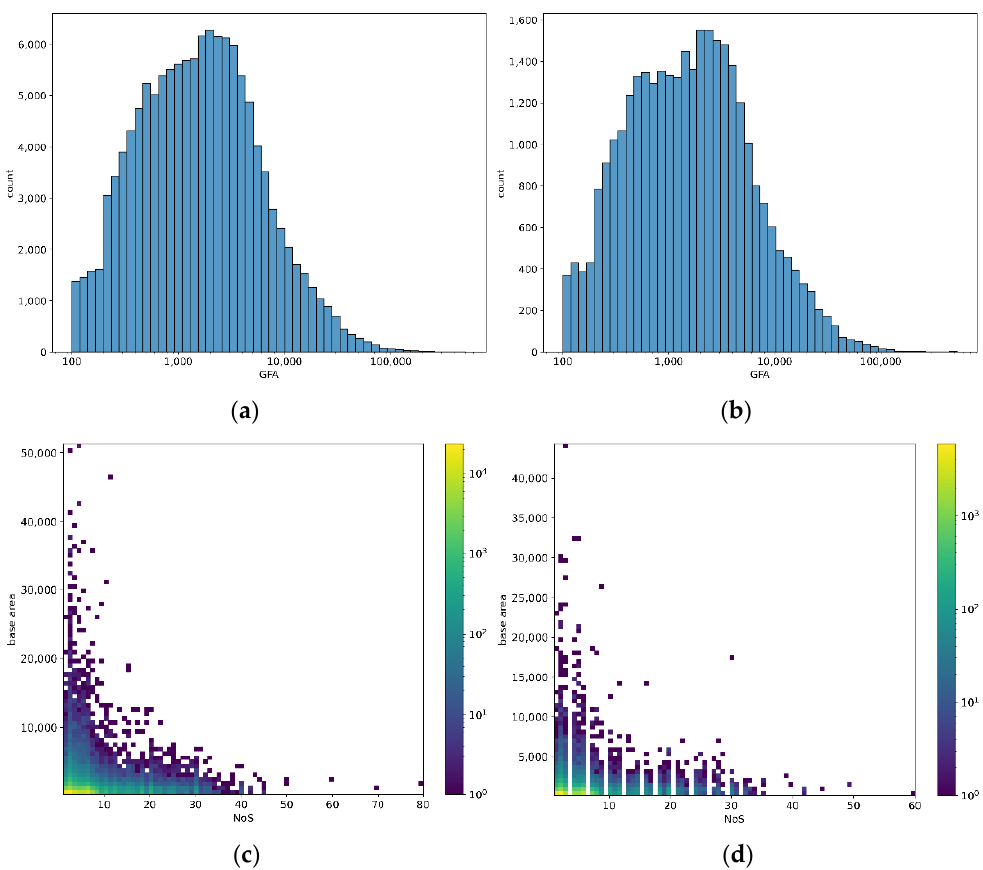
Figure 6. Statistical distribution of samples in the dataset. ( a ) Distribution of GFA in training dataset.